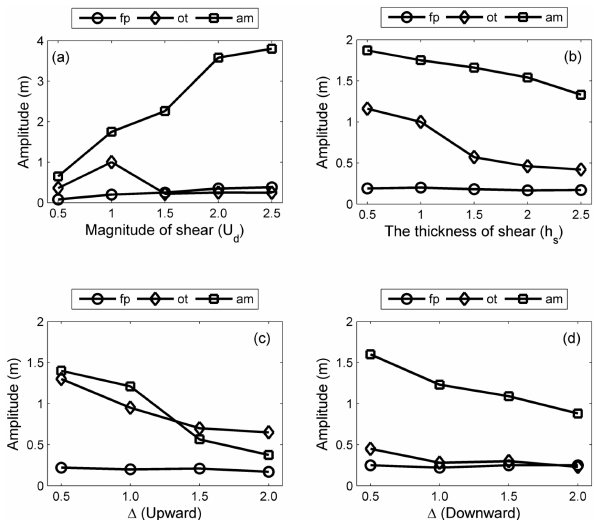
Figure 10. The summarized results of the amplitudes of the forward-propagating long wave (denoted by “fp”), oscillating tail (denoted by “ot”) and amplitude-modulated wave packet (denoted by “am”) with the presence of (a) varied magnitudes of shear cur- rents at 40 T , (b) varied thicknesses of shear currents at 40 T , (c) upward offset background shear currents at 30 T and (d) downward offset background shear currents at 30 T